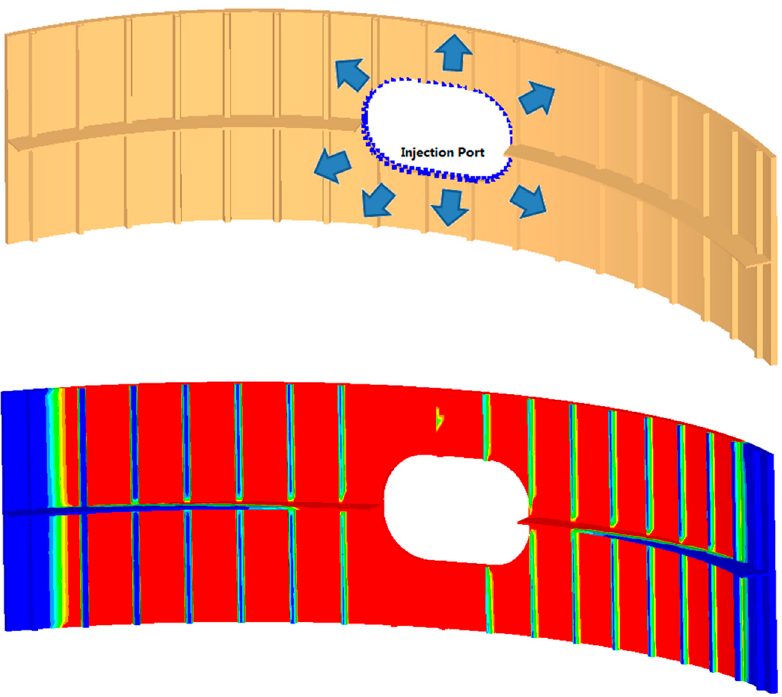
Figure 16. Injection case A for the fuselage section.